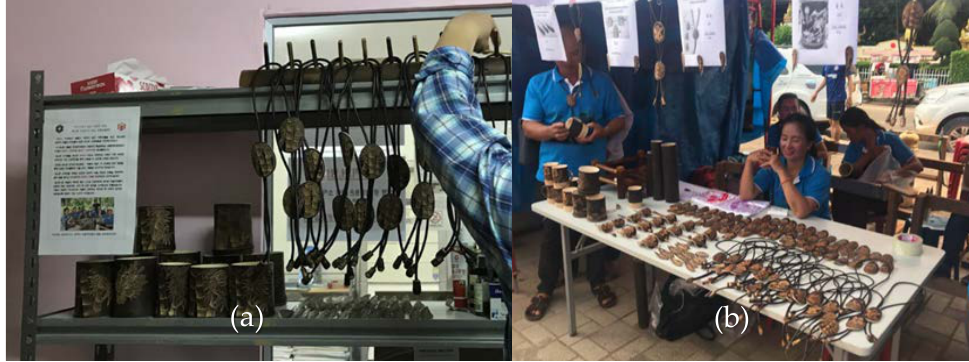
Figure 8. Distribution and sales of the new bamboo products: ( a ) display and sales of bamboo products in a souvenir shop and ( b ) night market booth in Vientiane, Lao PDR.